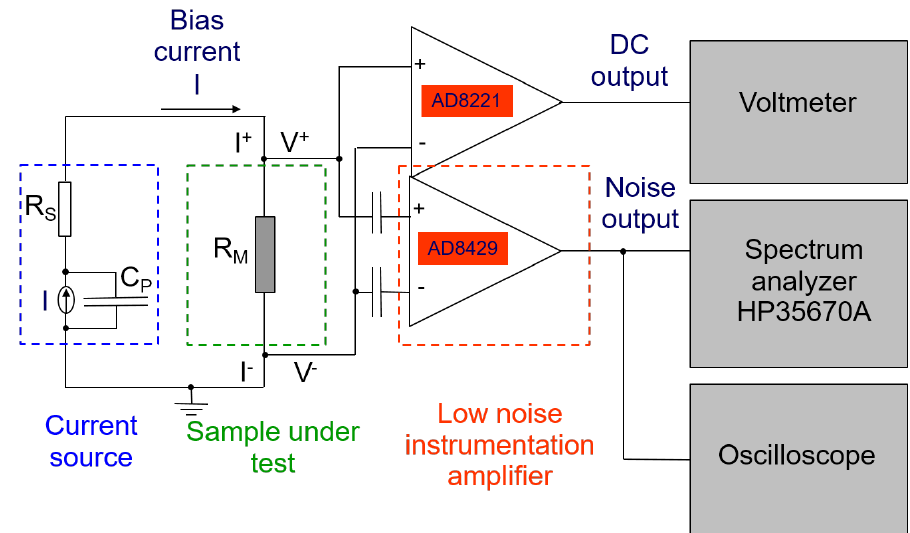
Figure 2. Schematic of the bias and readout electronics. The colored dashed boxes enclose the bias circuit (blue), the device under test (green), and the instrumentation amplifier (red). See text for details.